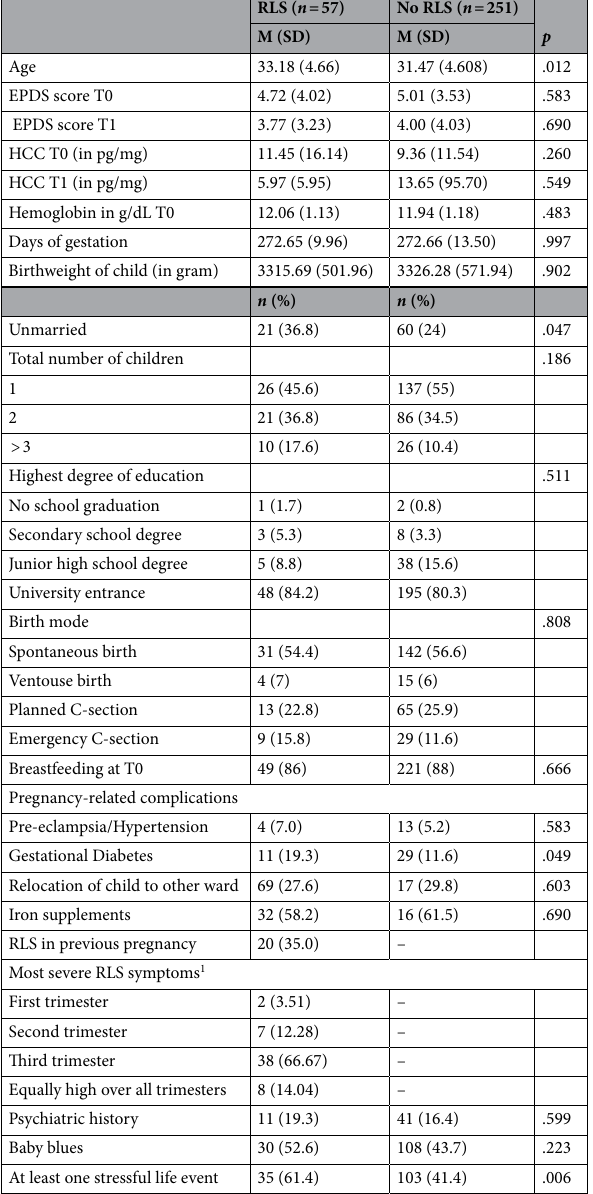
Table 1. Differences between women with and without RLS. Notes. n = absolute frequency, M = mean, SD = standard deviation; EPDS = Edinburg Postnatal Depression Scale; HCC = Hair cortisol concentration; T0 = baseline measure in childbed; T1 = 12 weeks postpartum. 1 Participant were asked the following question: “At which point during your pregnancy did you experience the RLS symptoms as most frequent or